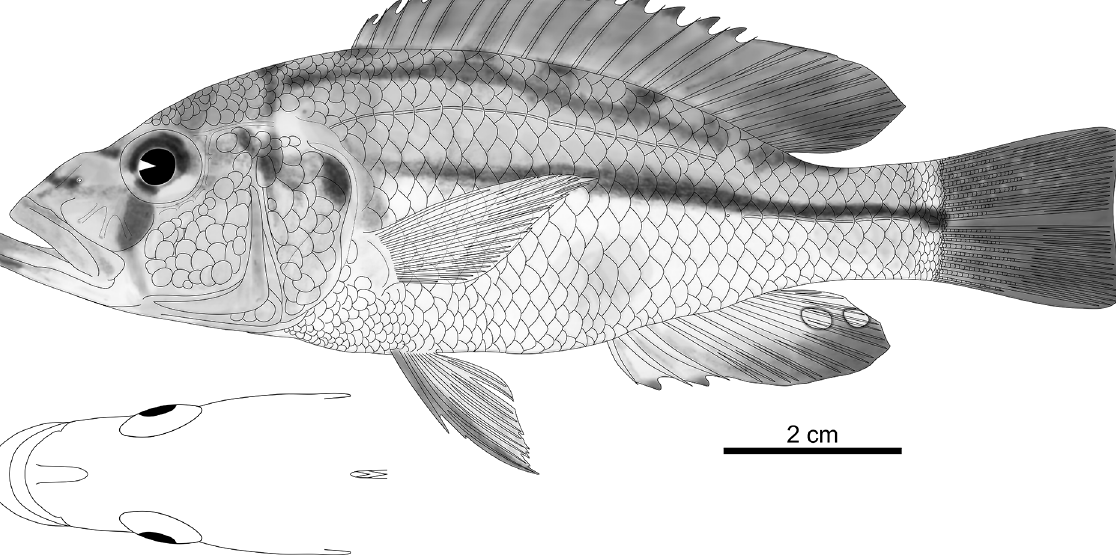
Fig. 26. Haplochromis falcatus sp. nov., holotype, ♂, 101.3 mm SL (RMCA 2018.008.P.0401). Drawn by N.